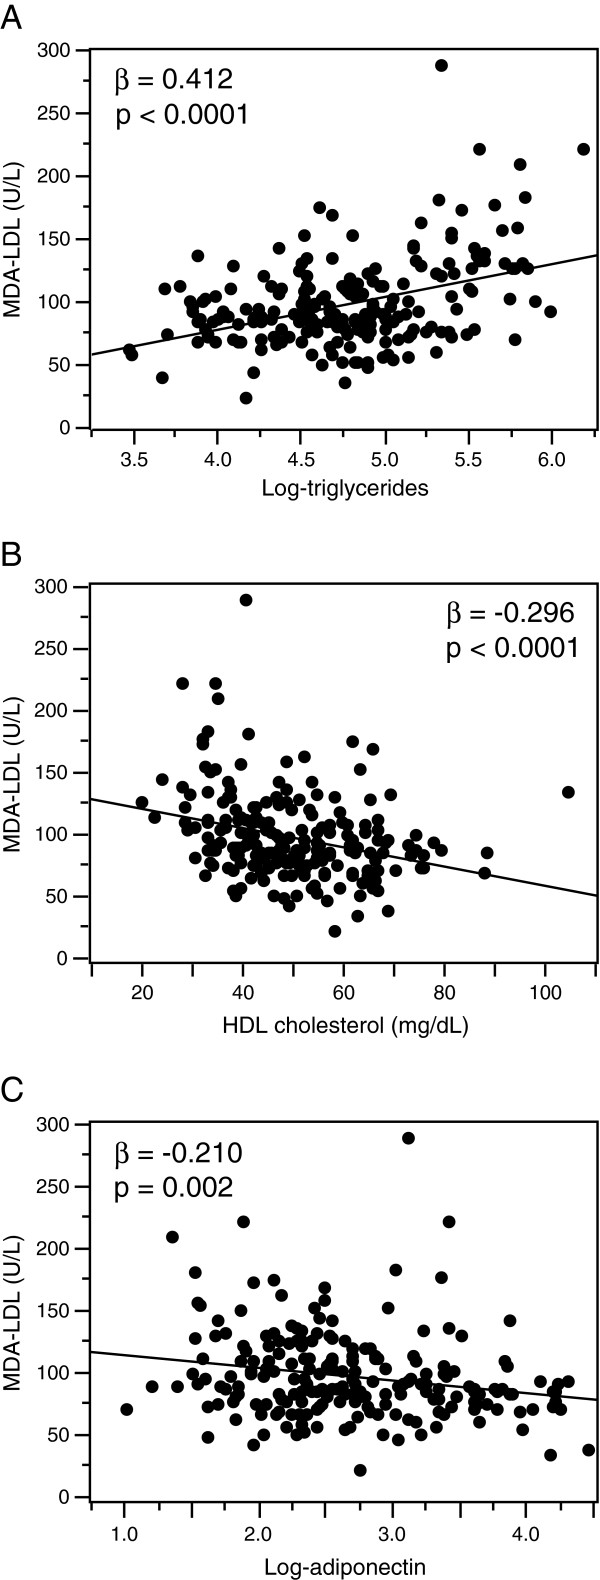
Correlations between the malondialdehyde-modified low-density lipoprotein (MDA-LDL) level and associated factors after adjusting for LDL cholesterol levels. The MDA-LDL level (U/L) was significantly correlated with the levels of log-transformed triglycerides (A), high-density lipoprotein (HDL) cholesterol (mg/dL) (B), and log-transformed adiponectin (C) with the indicated partial correlation coefficient (β) and p value. Statistical analyses were performed by multiple regression models adjusted for LDL cholesterol level.